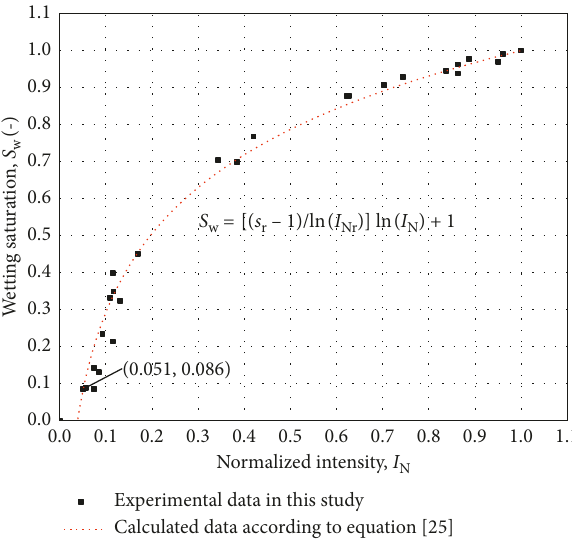
Figure 6: Correlation between experimental data and the general formula (cited by